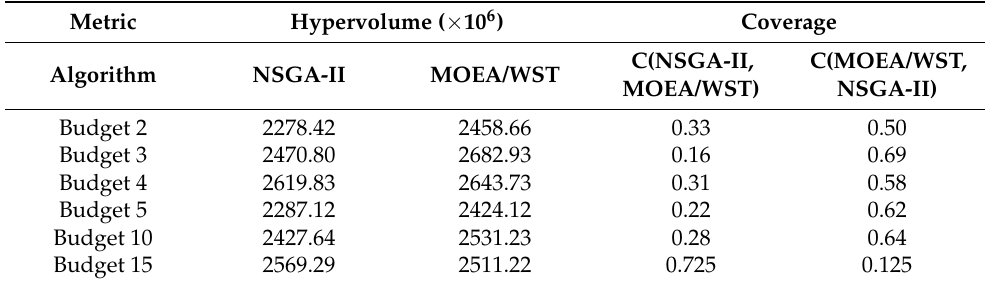
Table 1. Metric (Hanoi—50 generation).